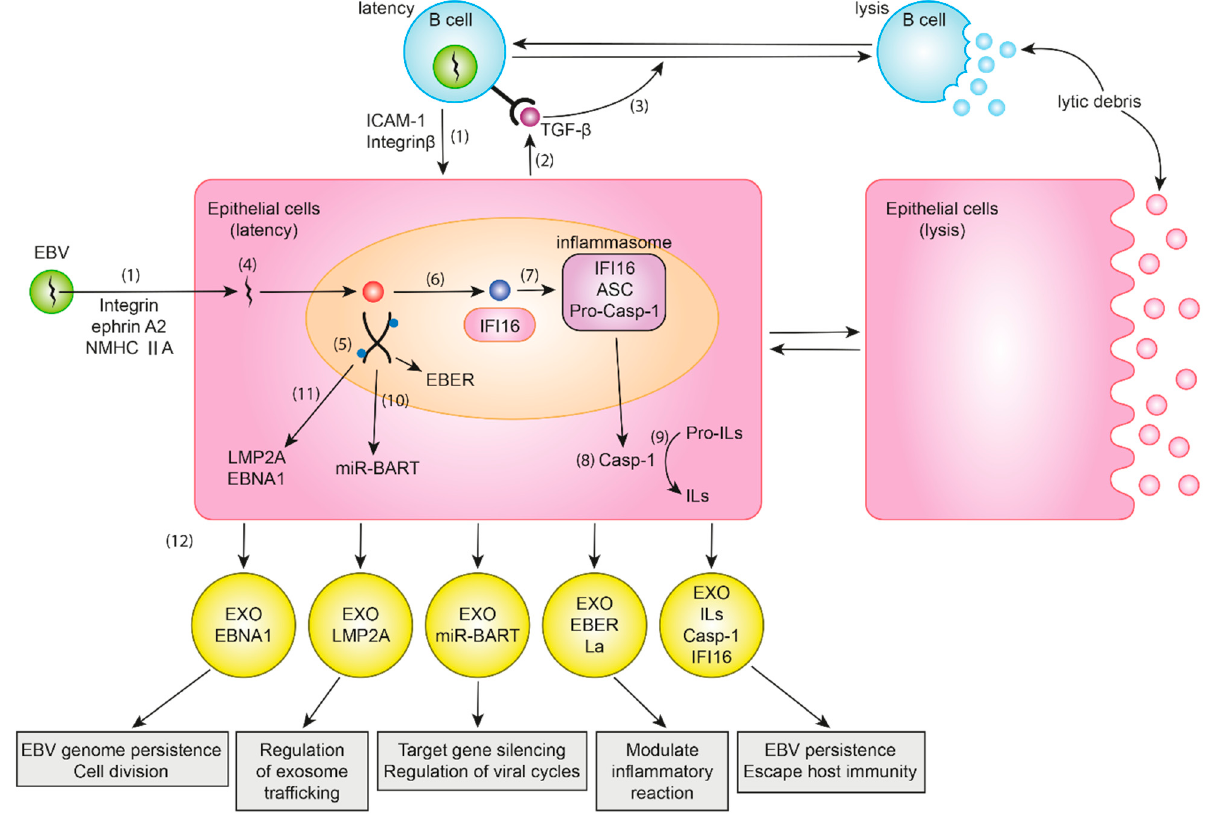
Figure 1. The process of epithelial EBV infection and impacts of exosomes in EBV-associated gastric cancer. (1) EBV itself or EBV-infected B cells cause EBV infection in the gastric epithelial cells. (2) TGF- β released from EBV-infected gastric epithelial cells induces expression of TGF- β receptors on B cells and (3) causes lysis of B cells leading to efficient viral transmission into epithelial cells. (4) EBV DNA transported to the nucleus undergoes (5) circulation and chromatinization. (6) Interferon gamma inducible protein 16 (IFI16) detects EBV DNA, and (7) recruits ASC and Pro-Casp-1 to form an inflammasome complex. (8) The inflammasome translocates to the cytoplasm and activates Casp-1, (9) which cleavage pro-ILs into ILs. (10) Viral transcription products (EBERs and miR-BARTs), (11) translation products (LMP2A and EBNA1), or other products (ILs, Casp-1, and IFI16) are (12) transported into recipient cells via exosomes. Abbreviations: ICAM-1, intracellular adhesion molecule-1; NMHC IIA, non-muscle myosin heavy chain IIA; IFI16, interferon gamma inducible protein 16; ASC, apoptosis-associated speck-like protein with a caspase recruitment domain; Casp-1, caspase-1; ILs, interleukins; EXO,